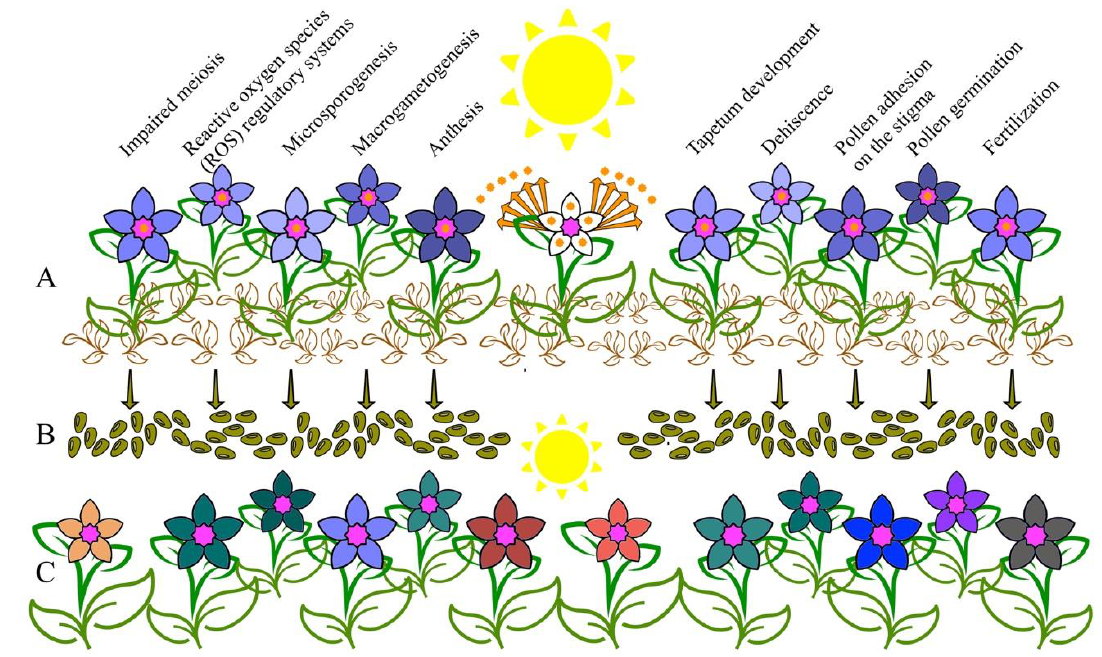
Figure 1. Conceptual model of Diversity Assurance. ( A ) Under excess heat, most plants die without flowering. A few (colored) survive as female only plants, rendered male sterile by one or more of at least 10 mechanisms that are known to a ff ect pollen development and fertilization. Tolerance to these e ff ects allows even fewer plants (white) to produce pollen (orange), which can then cross-fertilize through wind-borne pollen any of the male-sterile plants. ( B ) The cross-fertilized male-sterile flowers (colored) produce fertile seeds, which give rise to a new generation. ( C ) The new generation has enhanced diversity and stress-tolerance, because recombinant o ff spring carry stress tolerance from both parents and the male-sterility-under-stress trait of the female parent. Diversity Assurance events occur again in subsequent generations with new rounds of recombination, as result of which additional new combinations of stacked stress-tolerance genes will be created that will be open to selection.